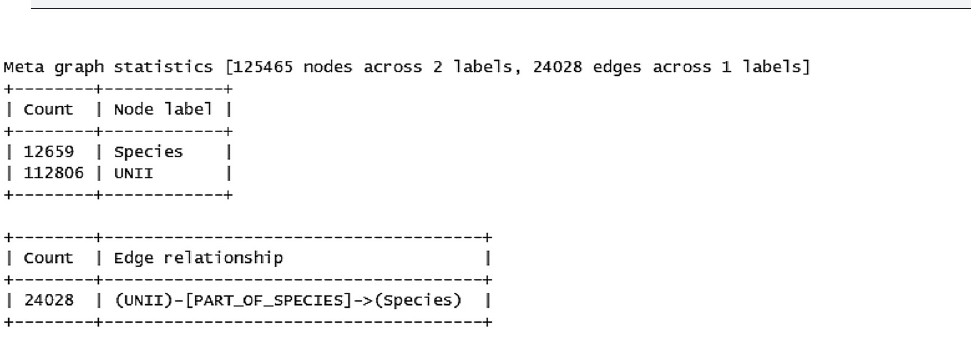
Figure 4: Example meta graph statistics for the ‘‘UNII’’ data